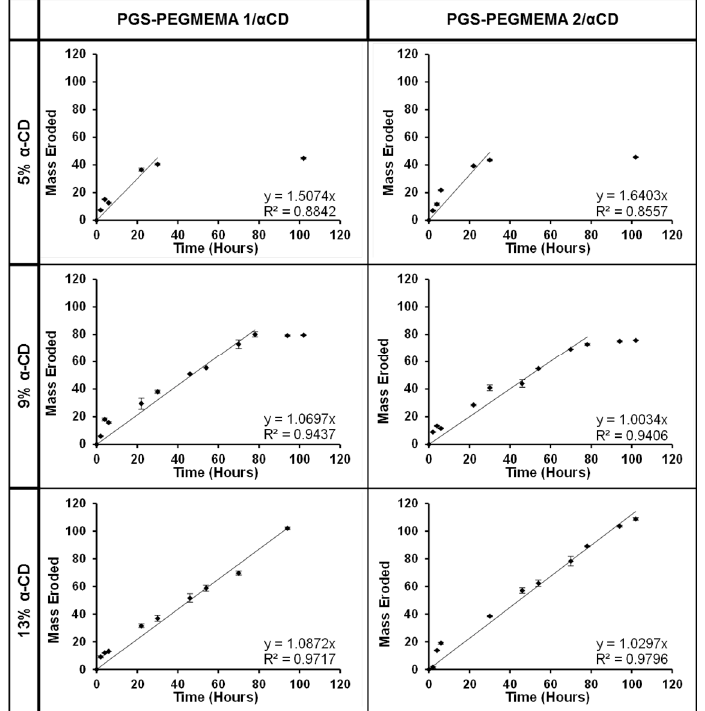
Figure 5. The erosion profile of hydrogels prepared with PGS-PEGMEMA 1 and 2 with α CD concentrations of 5%, 9% and 13%. The erosion rate was rather consistent independent of the α CD concentrations.